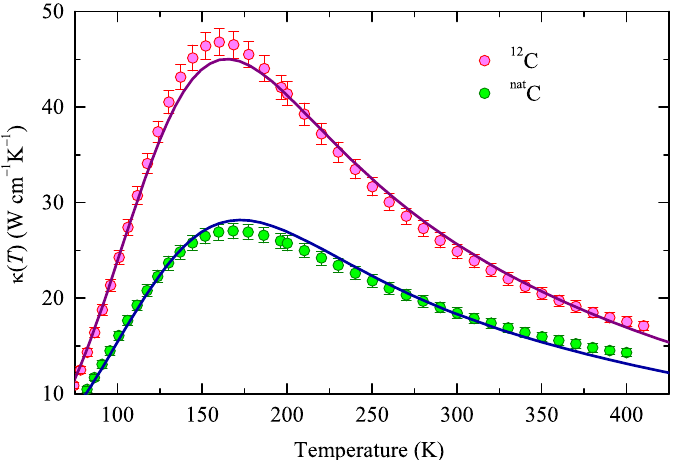
Figure 2. Temperature dependence of the thermal conductivity of CVD diamond samples with different isotopic compositions at temperatures above 75 K. Symbols are experimental data, lines are the results of